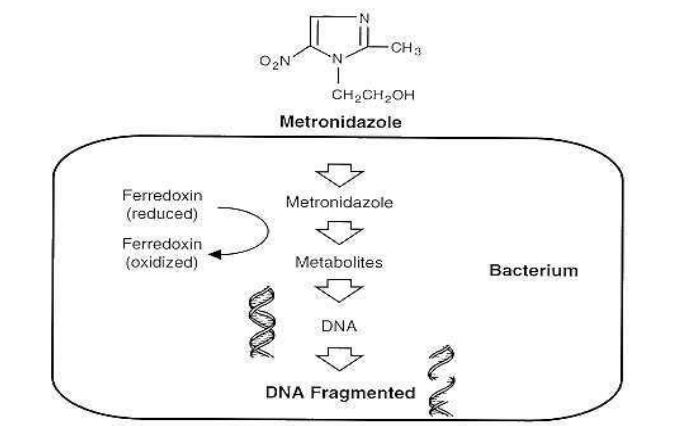
Figure 2. Structure of metronidazole and its mechanism of action.